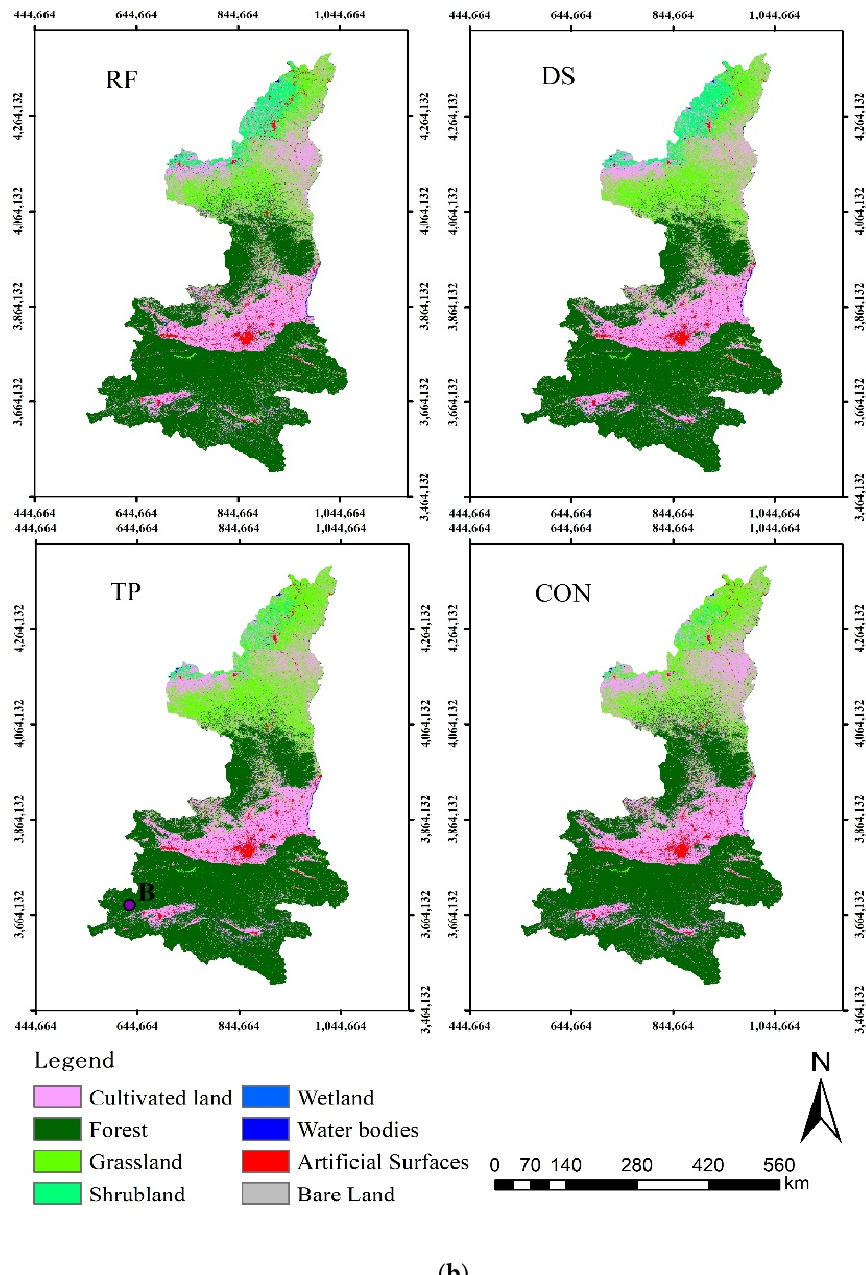
Figure 3. The fused land cover products for 2010 ( a ) and 2020 ( b ). Methods described in Section 2.3 were applied to fuse multiple land cover